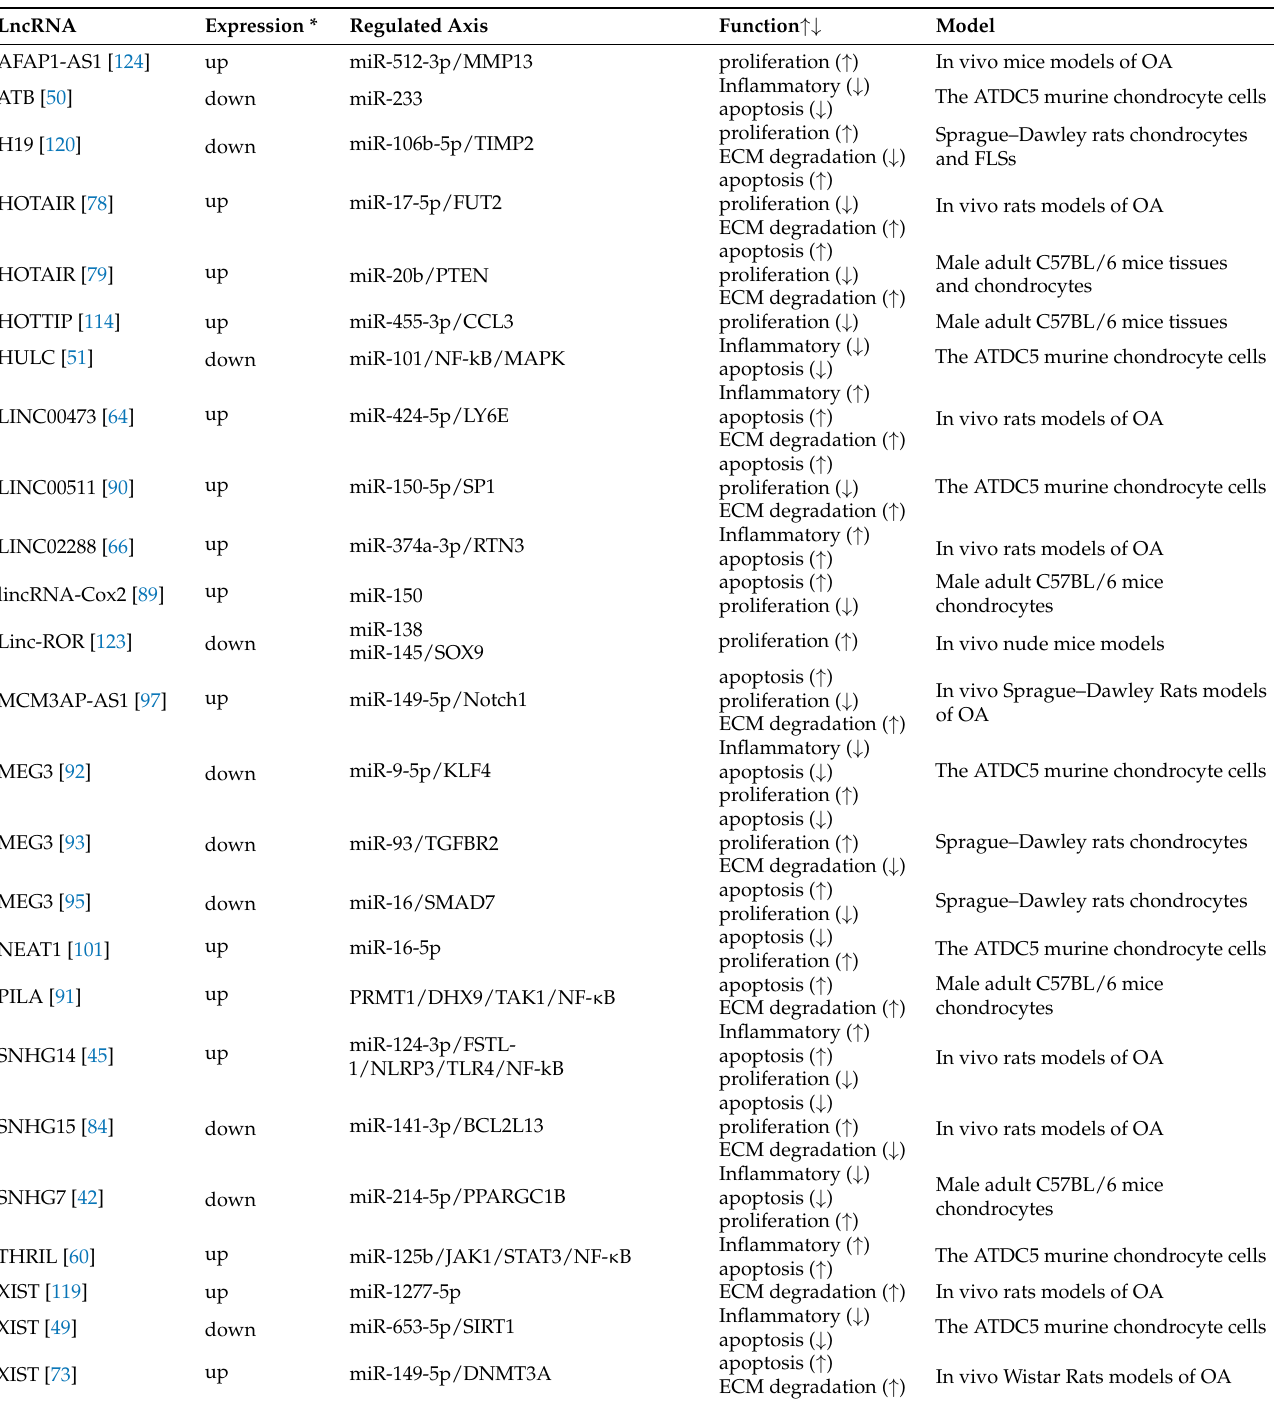
Table 1. Abnormal expression and function of lncRNAs in osteoarthritis cartilage described in this review (animal